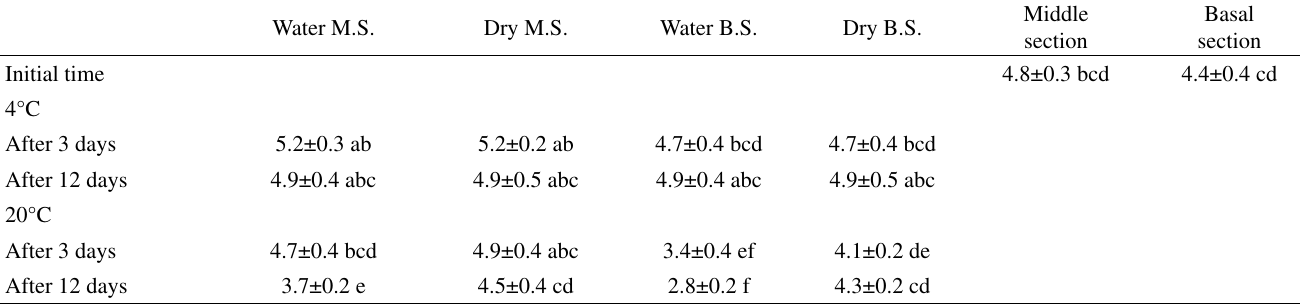
Table 2 - Dry matter content (%) of sections (basal and middle) of Calla lily flowers kept at 4 or 20°C, dry or in water Water M.S.